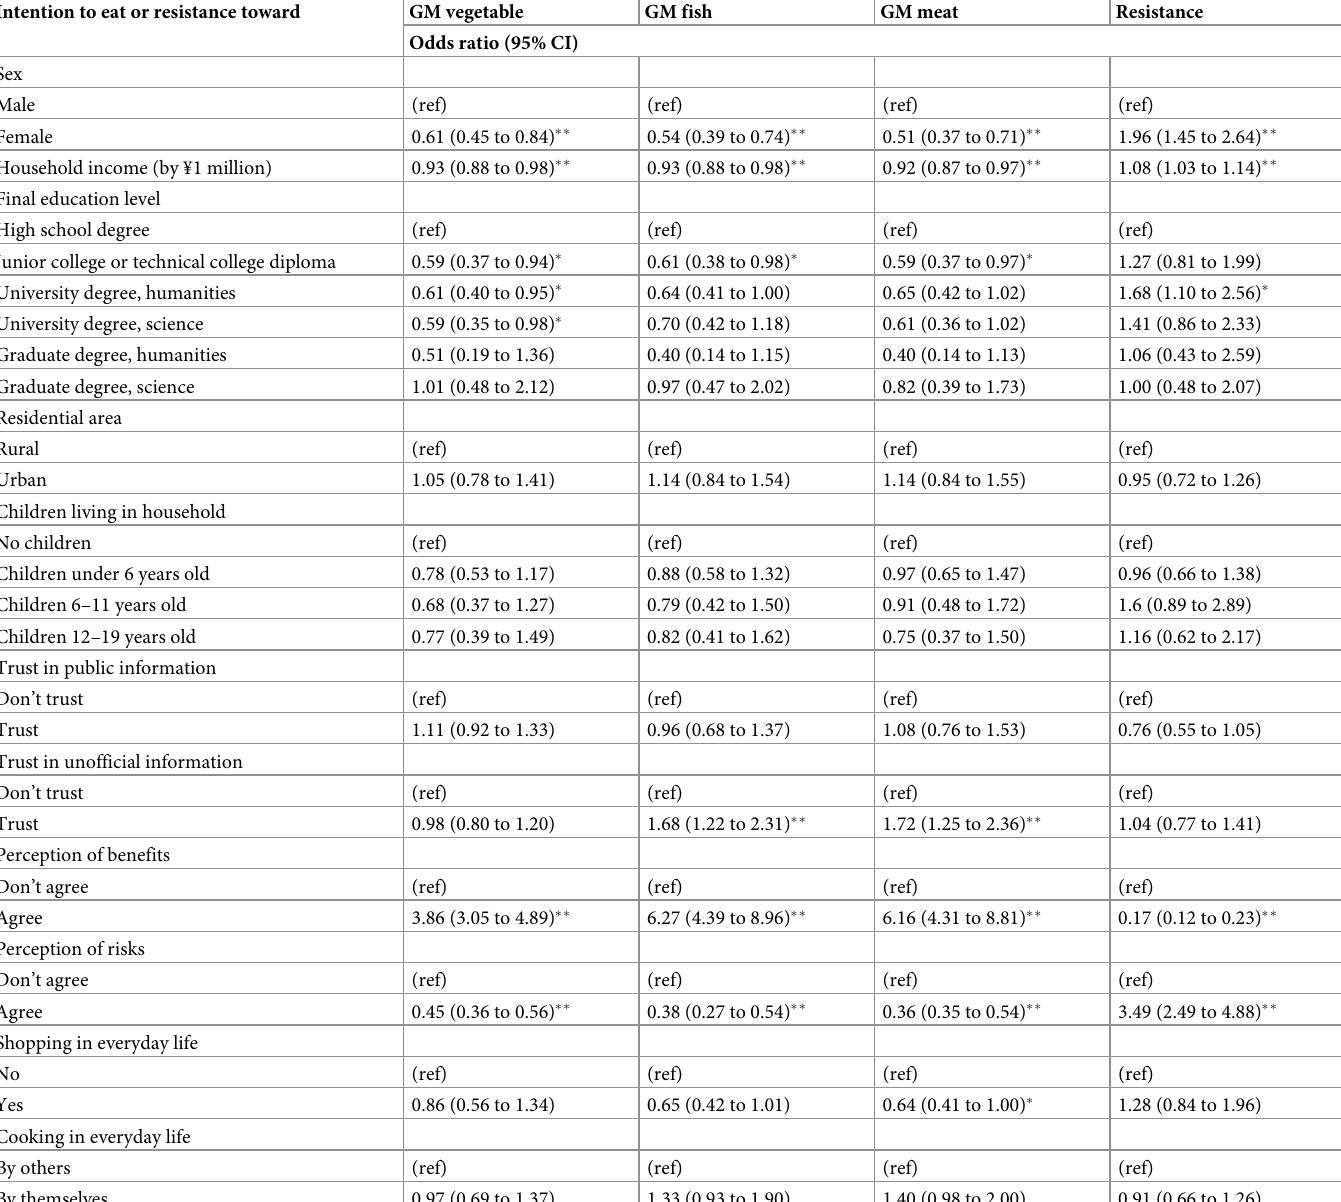
Table 7. Odds ratios of logistic regression analysis explaining acceptance of GM food according to sociodemographic characteristics, trust in institutions, percep- tion of benefits and risks, and practices of everyday life. Intention to eat or resistance